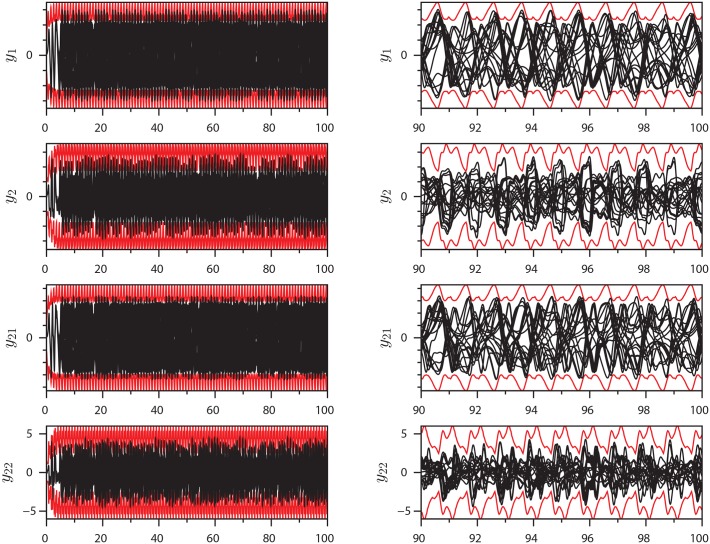
Extrema of Eq (13): Plots of extrema (red) and 20 different time series (black) of selected variables for parameter set IV.